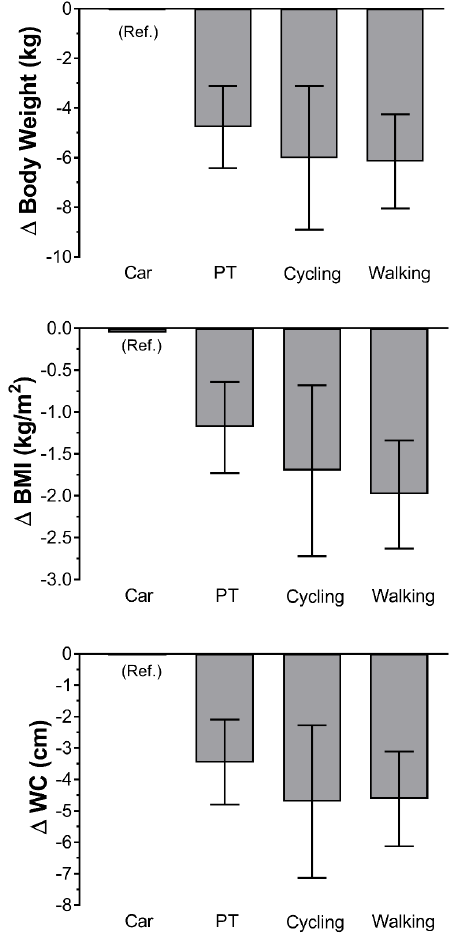
Figure 1. Association between travel mode and adiposity markers. Data presented as β coef ficient and their 95% confidence intervals. Car travellers were used as the reference group; therefore, the β indicate differences of each travel mode compared to cars travellers. Analyses were adjusted by socio-demographic factors (age, sex, education and place of residency), lifestyle factors (smoking, alcohol, fruit and vegetable intake and sedentary behaviours) and leisure PA. BMI: body mass index; WC: waist circumference; β: beta coefficient.